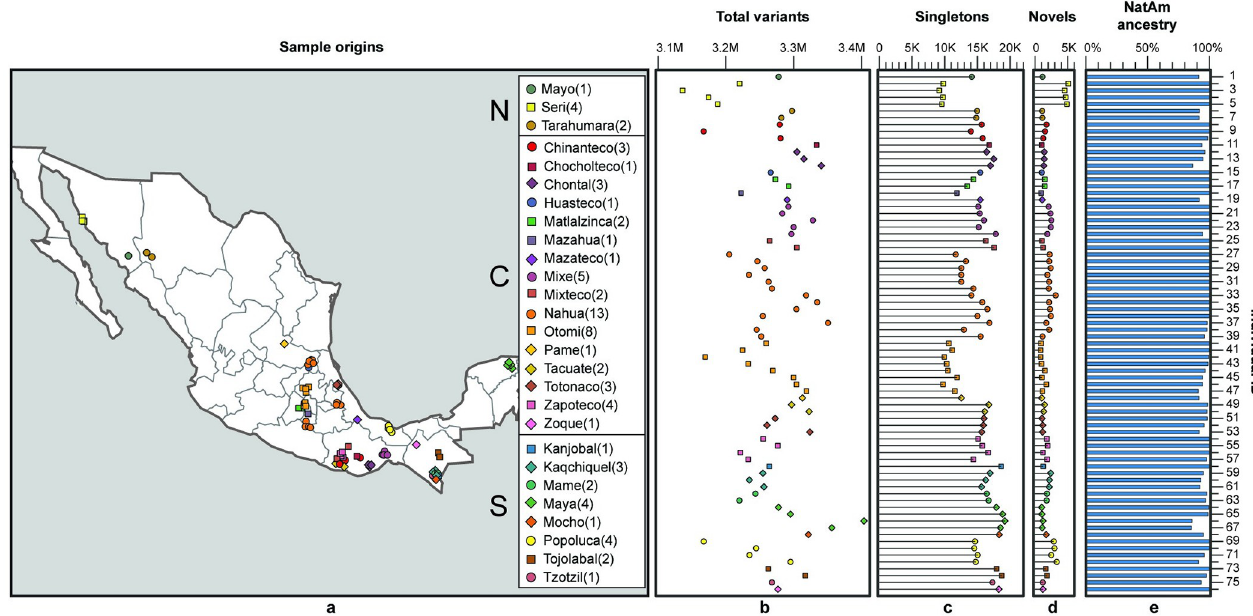
Fig 1. NM sampling. (a) Each point represents the approximate geographic origin of the 76 individuals, and the number in the legend indicates the number of samples per indigenous group. Legend separates individuals from Northern (N), Central (C) and Southern (S) regions. For the exact GPS coordinates see S1 Table in S2 Material. (b) Total variants (M = millions) for each of the 76 individuals; the y axis enumerates the sampled individuals and is shared with panels c, d, and e; shape and color of the points correspond to the indigenous groups in the map. (c) Number of singletons (K = thousands) for each sample inferred from worldwide comparison with gnomAD and the 1000 Genomes Project. (d) Number of novel variants (K = thousands) not registered in dbSNP b152. (e) Percentage of Native American